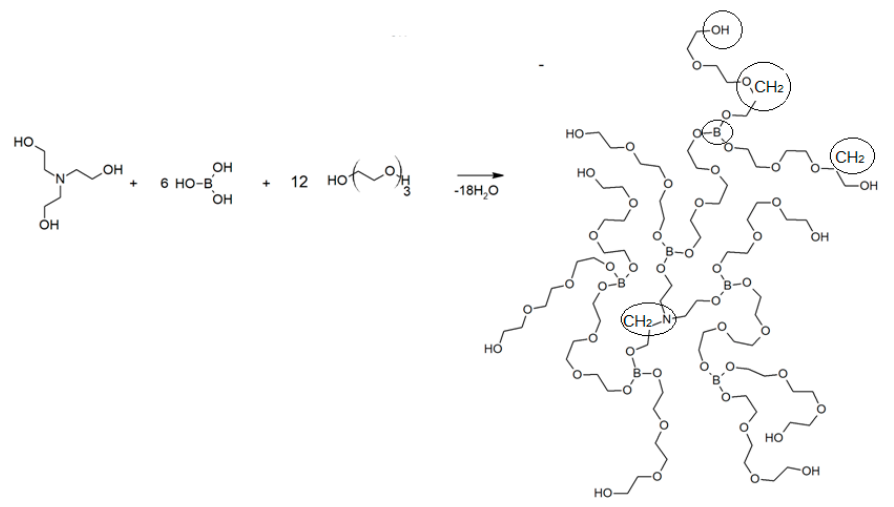
Figure 1. Scheme for the synthesis of AEBA–TEG.